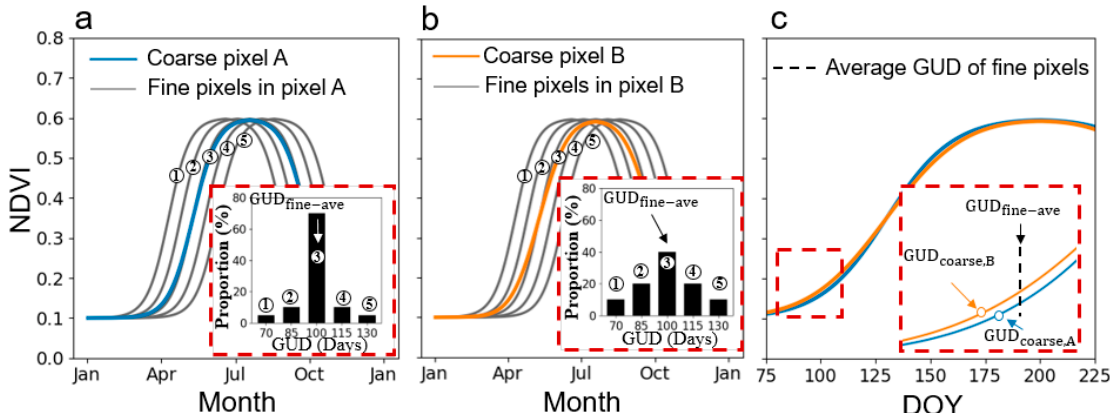
Figure 11. A simulation experiment is designed to help understand the influence of heterogeneity of GUD on scale effect. ( a , b ) Coarse pixels A and B consist of five fine VI curves with five different GUD values but the same VI curve shape. However, the shape of the coarse VI curves is different from the shape of fine VI curves. The heterogeneity of GUD is larger in pixel B than that in pixel A, as shown by the histograms of fine pixel GUD in the bottom-right; ( c ) The VI curves for coarse pixels A and B derived from the linear spectral mixture model, respectively. GUD coarse, B is earlier than GUD coarse, A and they are both earlier than GUD fine − ave (the vertical dashed line in the right of GUD coarse, A